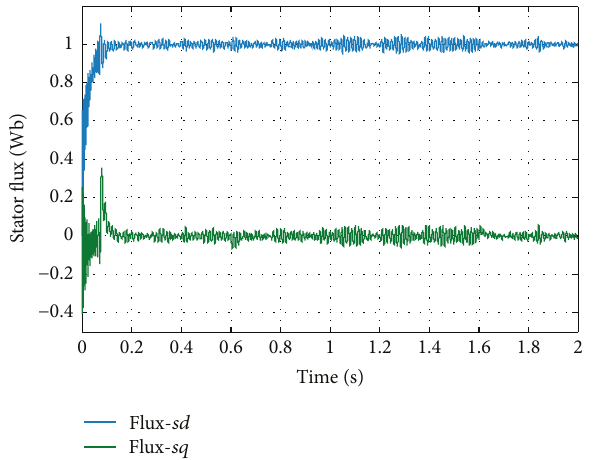
Figure 9: Result of stator flux under a load Cr = 5 N ⋅ m in the interval [0.6Sec–1.6